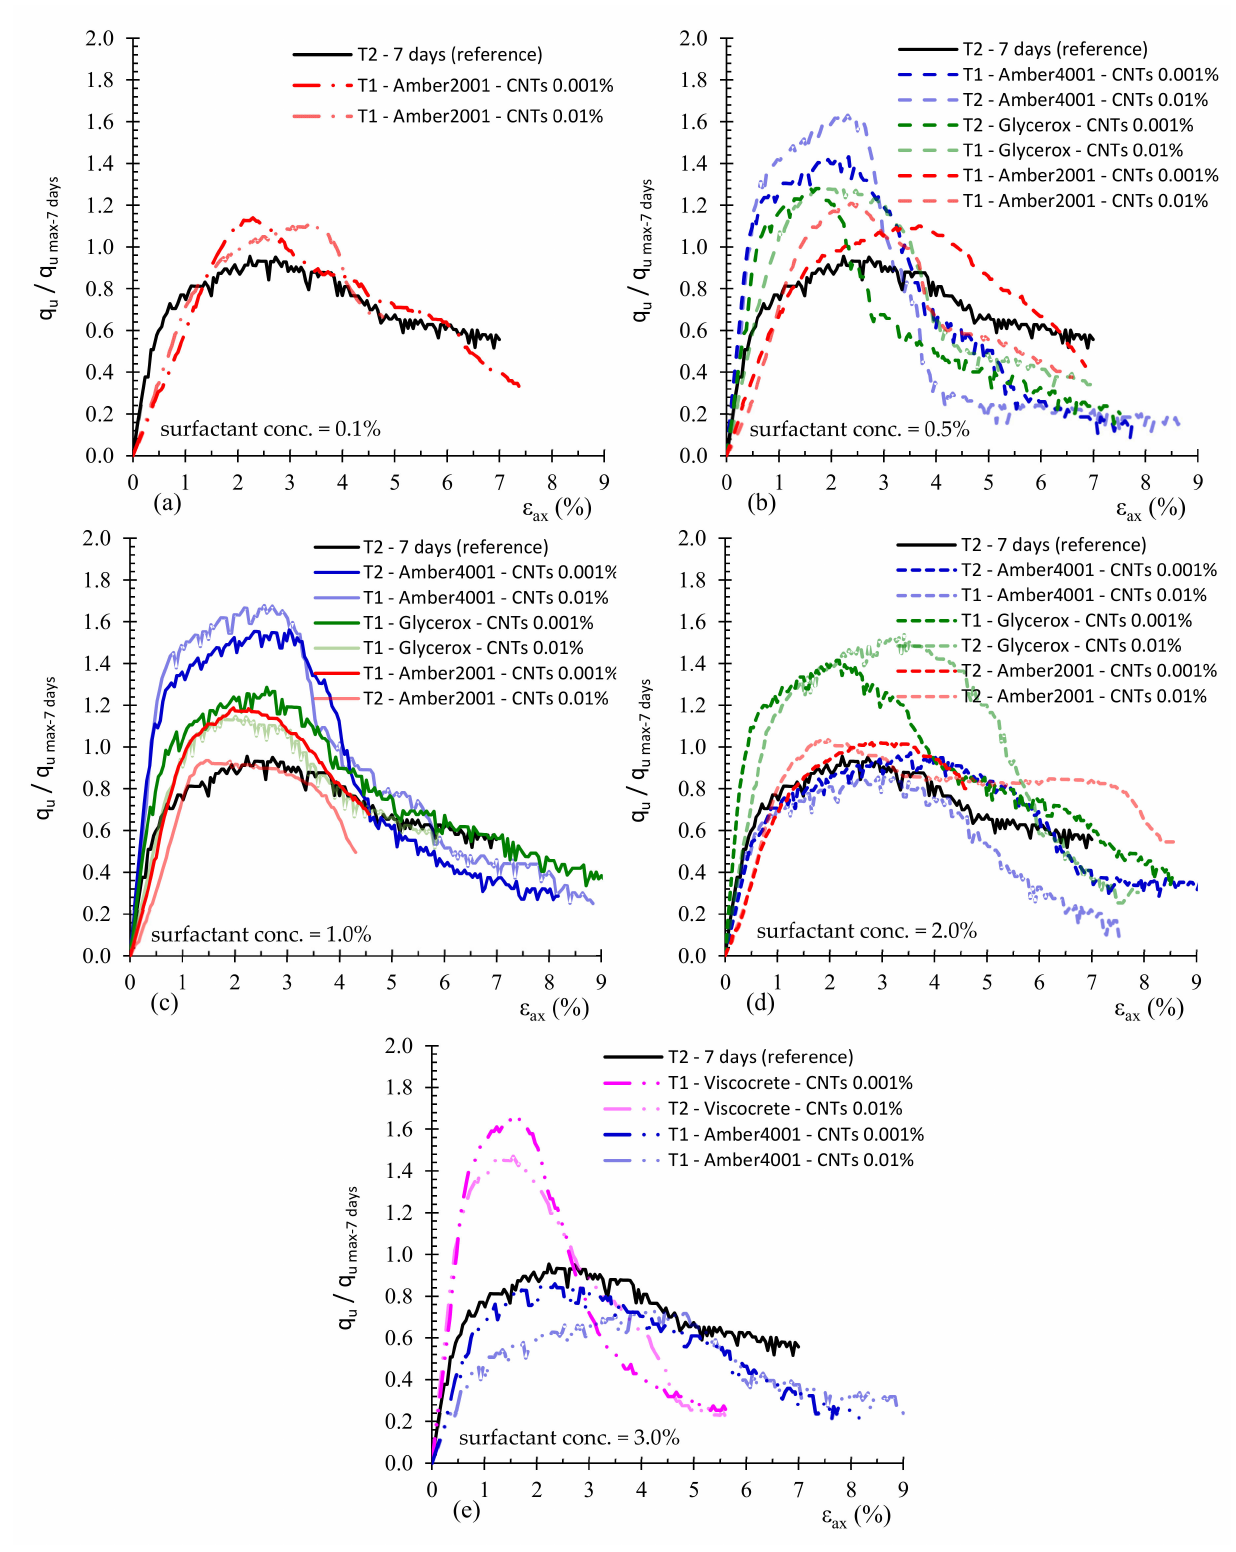
Figure 8. Stress–strain normalized curves (for samples with 7 curing days) for the stabilized soil with MWCNTs suspensions for different surfactants applied in concentrations of ( a ) 0.1%, ( b ) 0.5%, ( c ) 1.0%, ( d ) 2.0% and ( e )